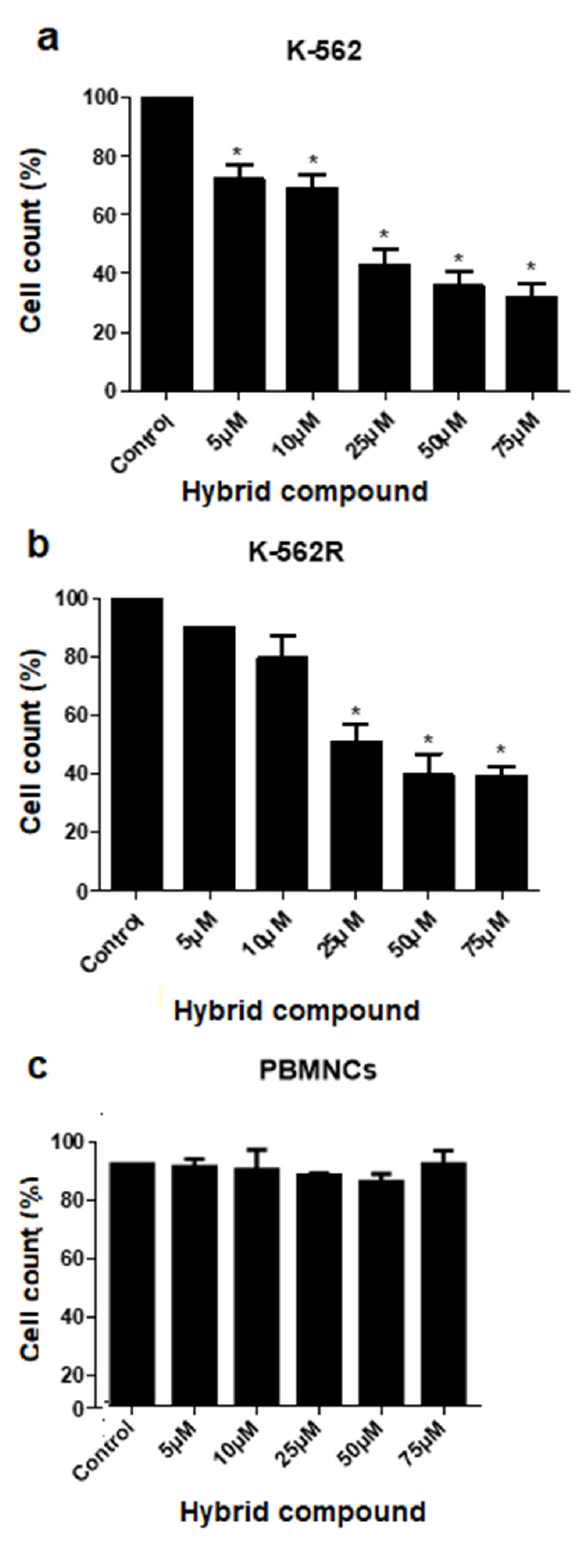
Figure 1. Inhibition of growth after 48 h treatment with different concentrations of the hybrid compound in ( a ) K-562 cells, ( b ) imatinib-resistant K-562 cells (K-562R) and ( c ) peripheral blood mononuclear cells (PBMNCs). Data are reported as mean ± standard deviation (SD) of three experiments (* p < 0.05; relative to untreated control cells).